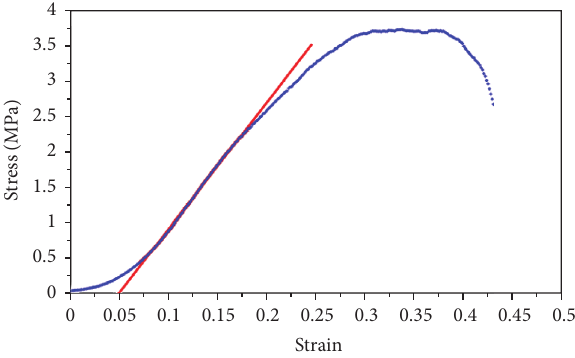
Figure 7: Typical stress-strain curve. Blue points represent the experimental data, and red straight line, the linear fitting used to obtain Young’s